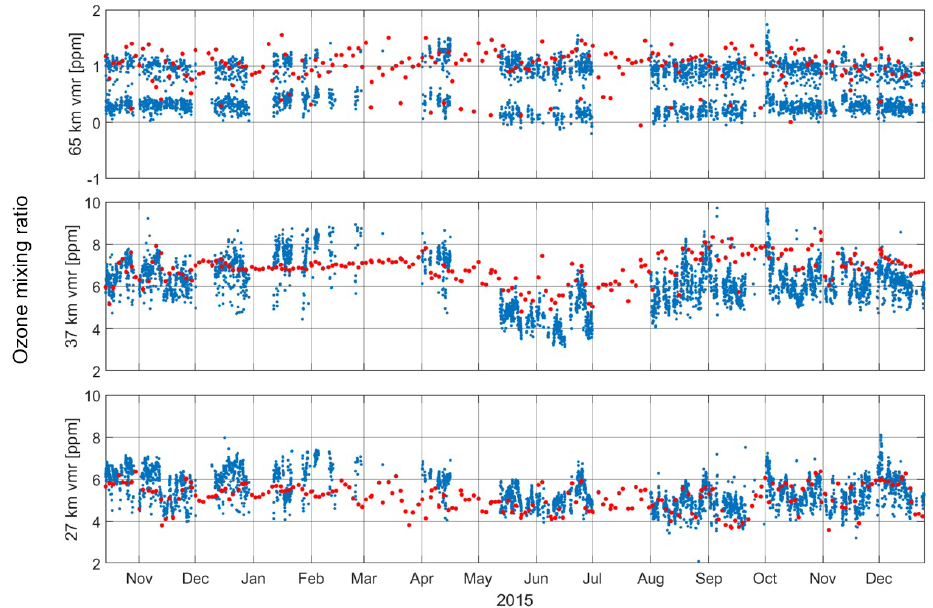
Figure 2. Time series of MLS (red dots) and MWR (blue dots) ozone mixing ratios for three altitudes: 27, 37 and 65km between October 2014 and December 2015 (the MWR was inoperative during March and July 2015 due to technical problems).